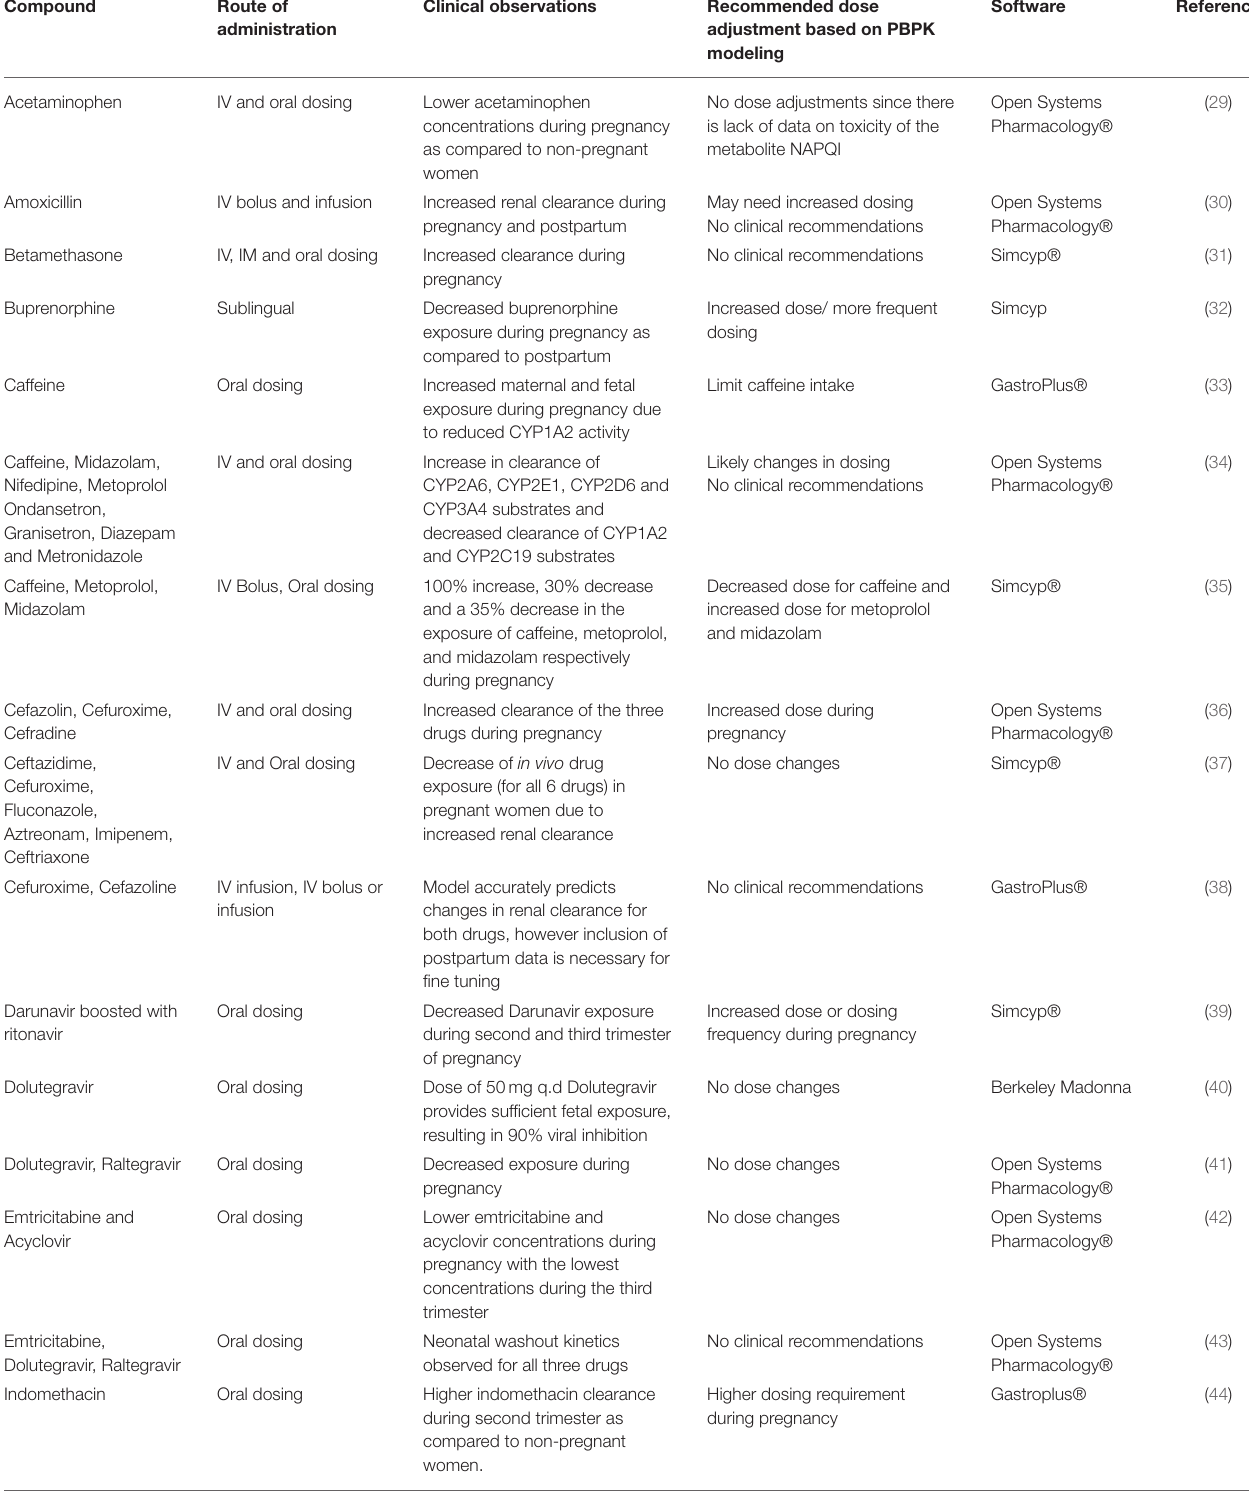
TABLE 5 | Review of published p-PBPK models.